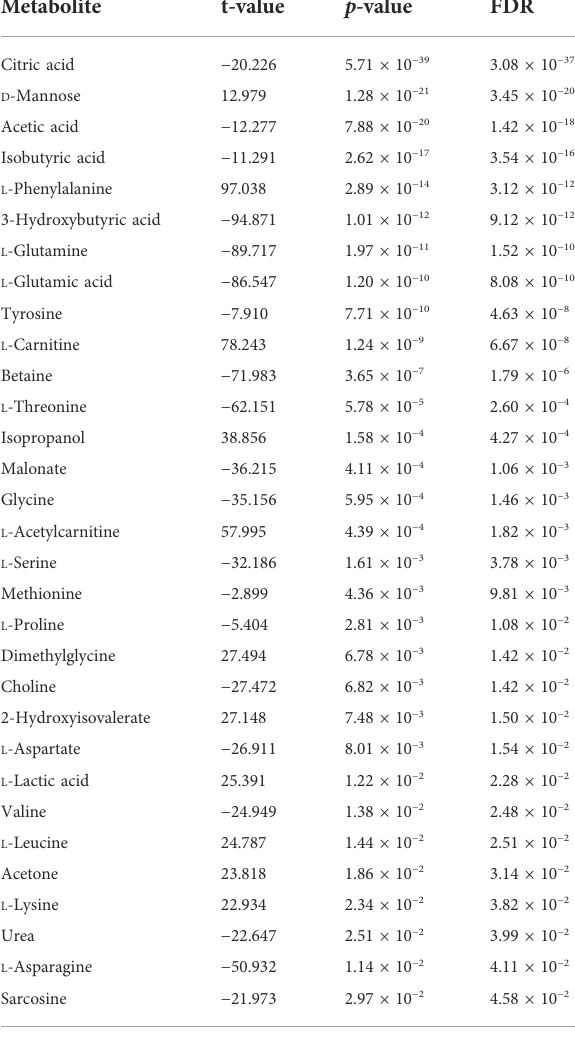
TABLE 4 Signi fi cant metabolites between BRD and non-BRD animals.